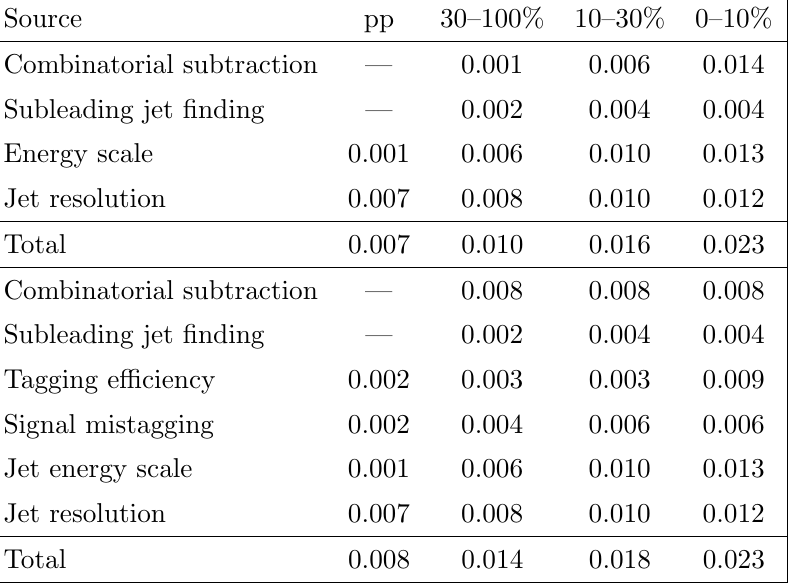
Table 1 . Absolute systematic uncertainties on h x J i for inclusive (upper sub-table) and b (lower sub-table)